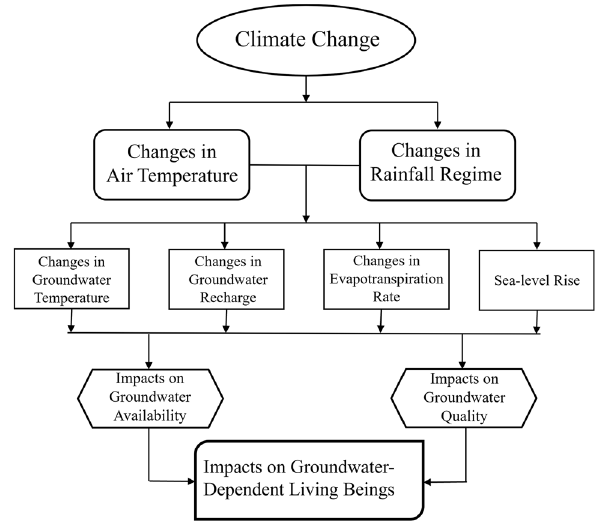
Fig. 1 Conceptual diagram of natural impacts of climate change